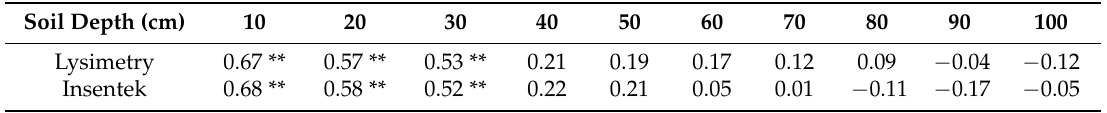
Table 3. Correlation coefficient (R) of evapotranspiration (ET c ) related to soil water content at each soil depth.